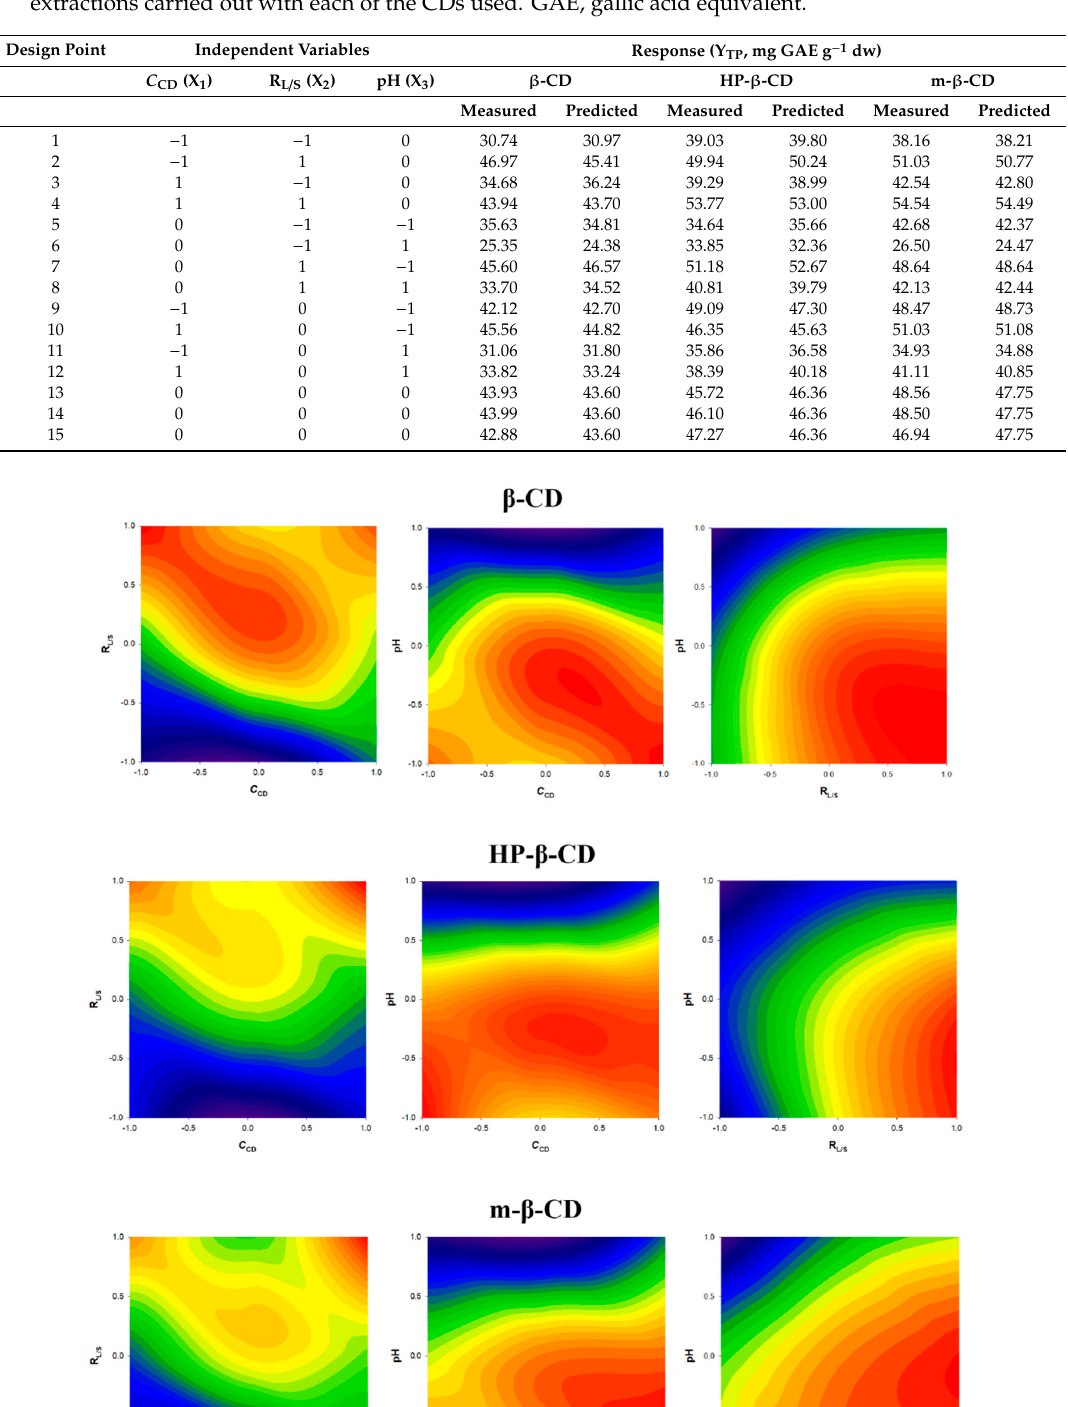
Table 3. Experimental design points and the corresponding predicted and measured Y TP values for the extractions carried out with each of the CDs used. GAE, gallic acid equivalent. Design Point